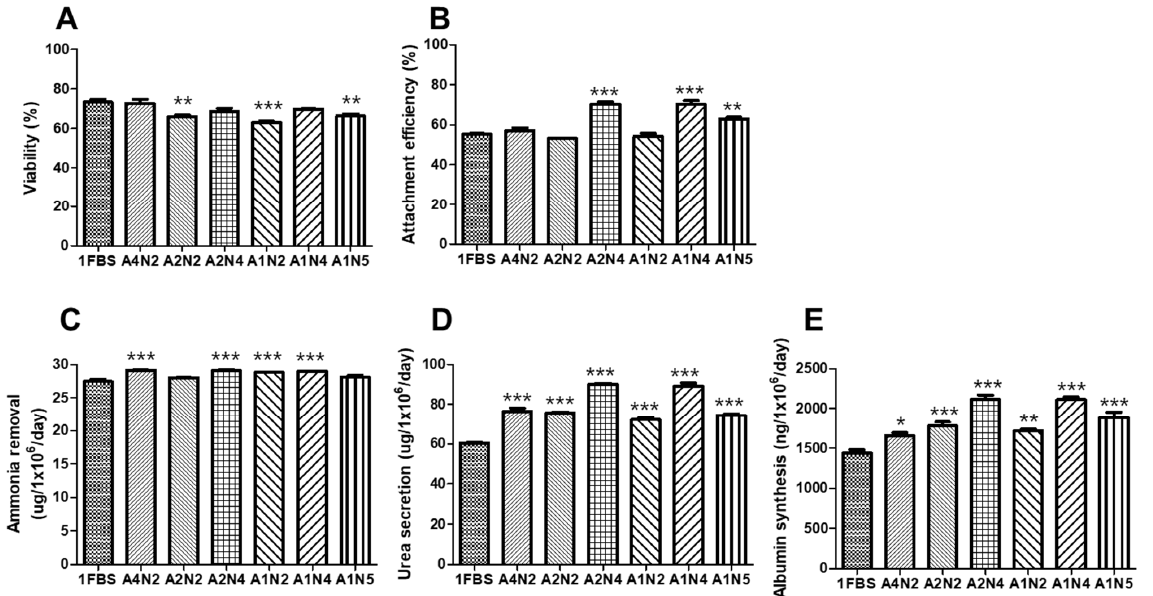
Figure 5. Effect of thawing medium on cryopreserved porcine hepatocyte spheroids’ viability and liver-specific functions in post-thawing culture. Porcine hepatocyte spheroids were cryopreserved in FBS supplemented with 15% DMSO and stored for 1 year in liquid nitrogen. Porcine hepatocyte spheroids were warmed rapidly using a water bath and washed in a thawing medium supplemented with 1%, 2%, and 4% human serum albumin (A1, A2, and A4, respectively) or 20, 40, and 50 mM N-acetylcysteine (N2, N4, and N5, respectively) and then resuspended in warm complete medium and evaluated for ( A ) cell viability; ( B ) attachment efficiency using a (3-(4,5-dimethyl thiazol-2-yl)- 2,5-diphenyltetrazolium bromide assay; ( C ) ammonia removal; ( D ) urea secretion; and ( E ) albumin synthesis after 24 h of culture. 1FBS, 10% FBS; A, human serum albumin; N, N-acetylcysteine. Statistical significance compared to the control thawing medium (1FBS): * p < 0.05, ** p <